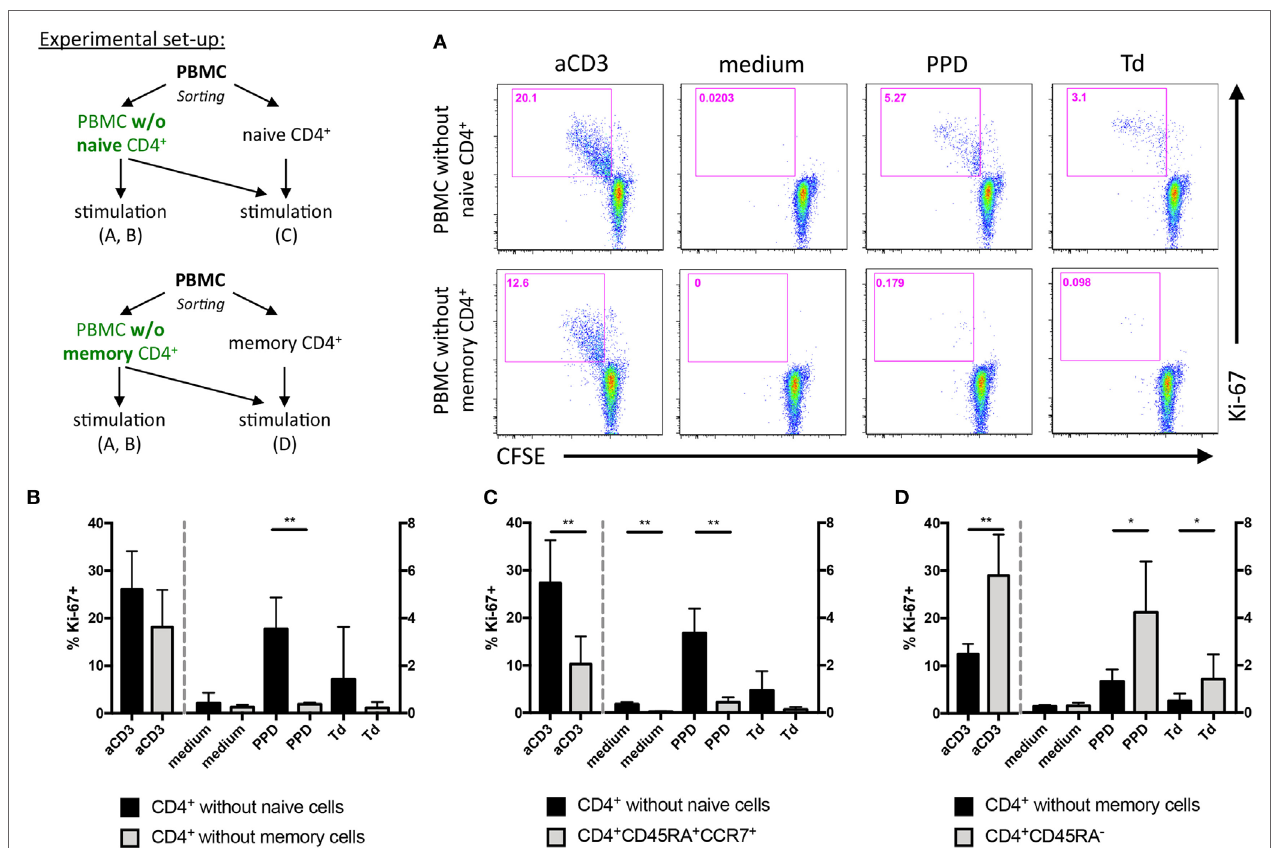
FigUre 5 | Stimulation of human peripheral blood mononuclear cells (PBMC) with purified protein derivative or tetanus and diphtheria toxoid induces proliferation of memory CD4 + T cells in vitro . PBMC were depleted of naive or memory CD4 + T cells by flow cytometric cell sorting and labeled with carboxyfluorescein succinimidyl ester diacetate (CFSE). As summarized in the scheme, the CFSE-labeled PBMC were then either stimulated alone or with addition of (unlabeled) naive or memory CD4 + T cells. (a) CFSE dilution among memory (upper row) or naive CD4 + T cells (lower row) and Ki-67 expression were analyzed after 4 days of culture in the presence of the indicated stimuli. (B) Summary graph of experiments set up as in (a) showing frequencies of Ki-67 + cells among CD4 + T cells from three independent experiments with cells from one donor each. (c) Frequencies of Ki-67 + cells among CD4 + CD45RA + CCR7 + naive T cells (gray columns) added back to naive CD4 + T cell-depleted PBMC (black columns: % Ki-67 + /memory CD4 + T cells). (D) Reverse experiment of (c) , i.e., frequencies of Ki-67 + cells among CD4 + CD45RA − memory T cells (gray columns) added back to memory CD4 + T cell-depleted PBMC (black columns: % Ki-67 + /naive CD4 + T cells). Columns are mean + SD of values from three donors assayed individually and tested with a one-tailed paired t -test (* p < 0.05, ** p <